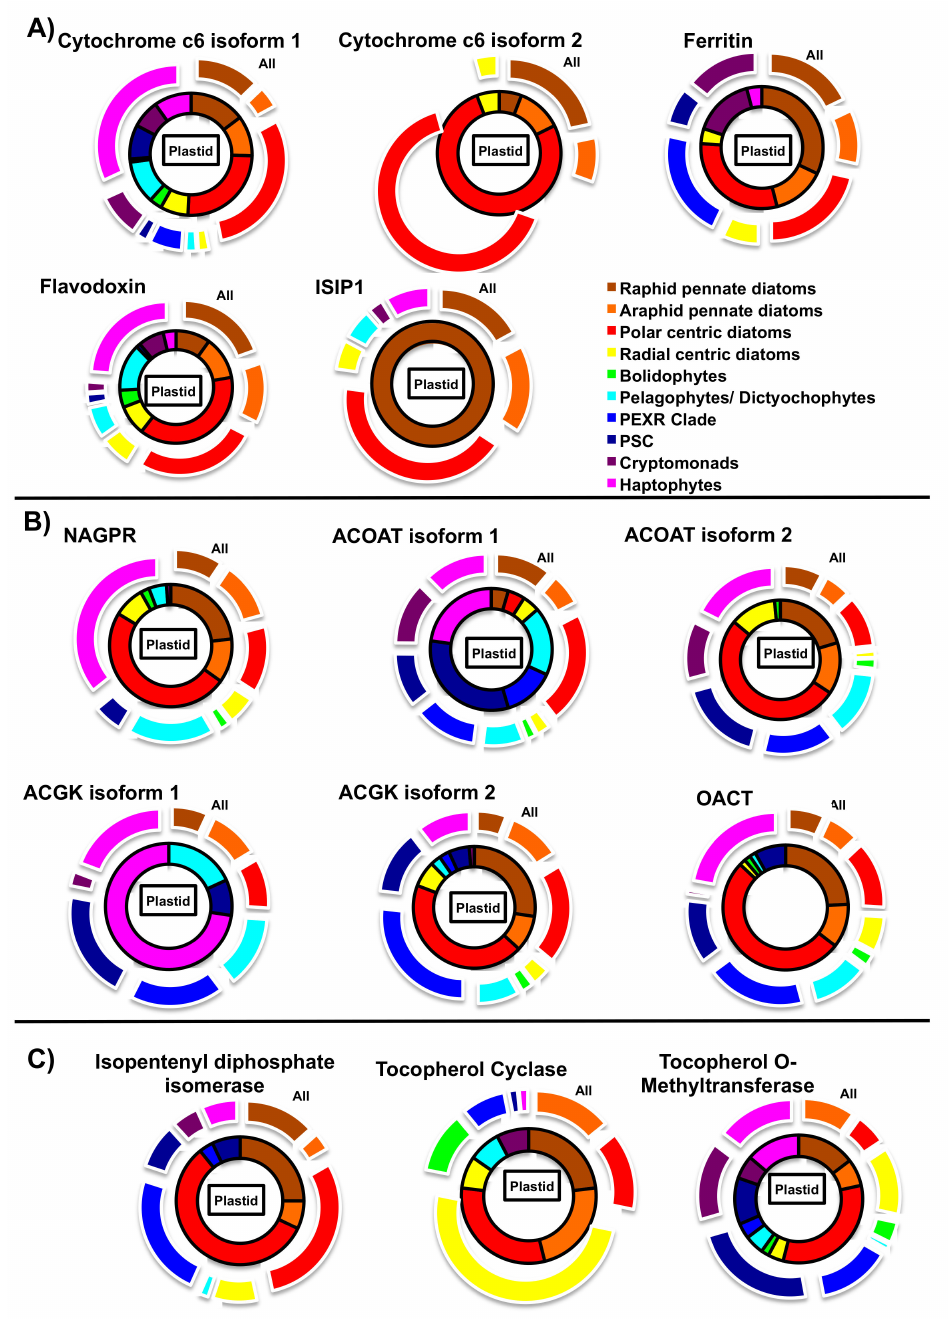
Figure 4. Evolutionary distributions of chloroplast proteins restricted to diatoms and their close relatives. This figure shows the evolutionary distributions of chloroplast-targeted proteins involved in ( A ) iron metabolism, ( B ) ornithine metabolism, and ( C ) organic compound synthesis, inferred from the pipeline used in Figure 3A, across photosynthetic stramenopiles, haptophytes, and cryptomonads. Lineages are arranged into monophyletic taxonomic groups, following published phylogenies [36,69]. The inner wheel of each diagram (bounded with black lines) shows the total numbers of species within a given lineage for which chloroplast-targeted proteins were identified, and the outer wheel of each diagram shows the number of species within a given lineage for any protein homologue (including those with non-chloroplast or ambiguous targeting signals) could be identified. Exemplar GFP localisations for enzymes associated with the probable diatom chloroplast ornithine cycle are shown in Figure S1. Presence and absence distributions of each protein, listed by species, are provided in Table